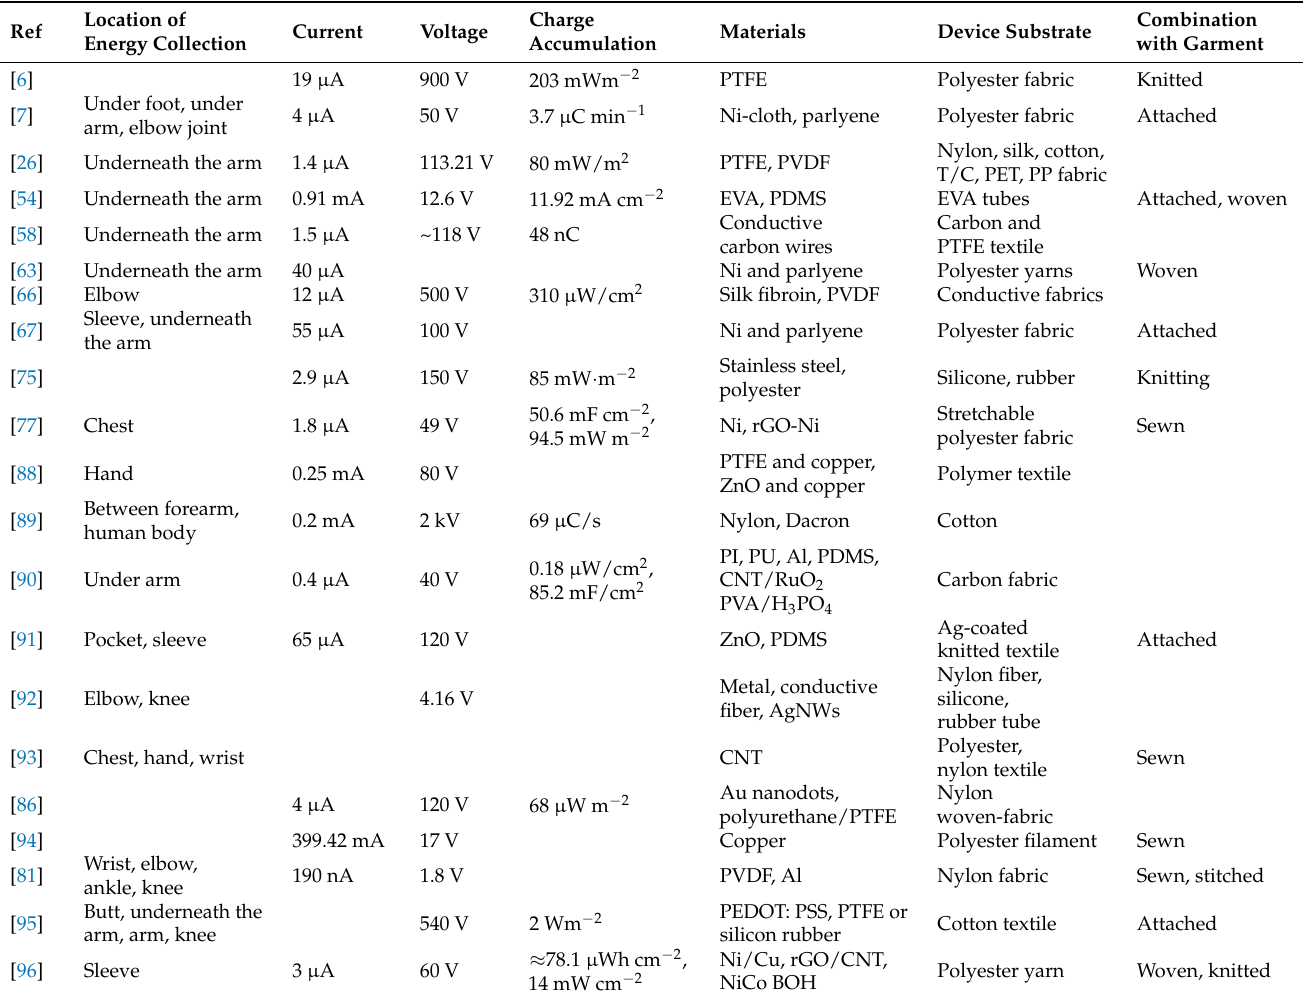
Table 1. List of the reported textile-based TENGs with different